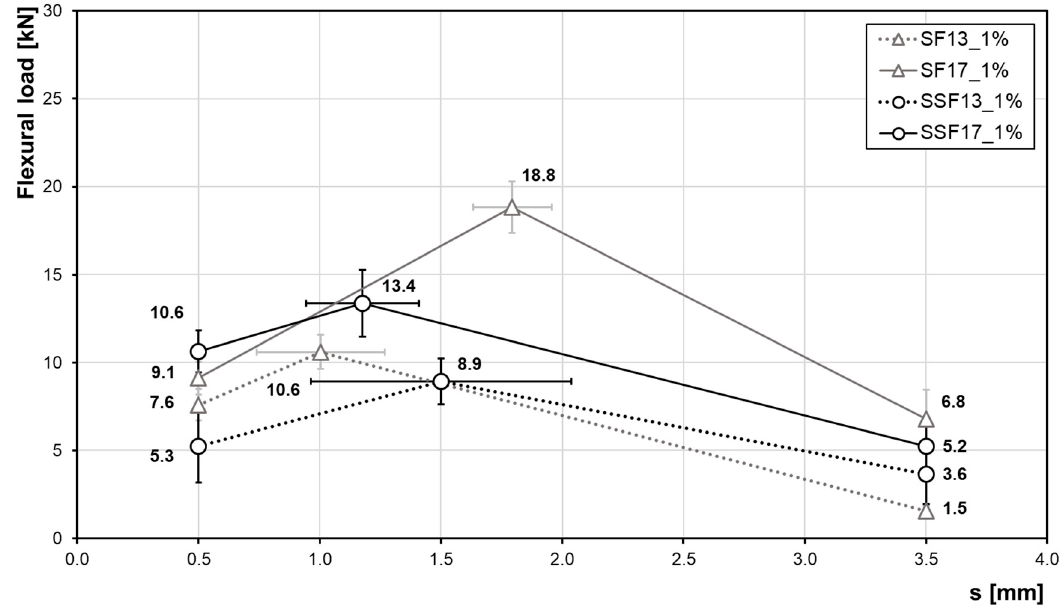
Figure 11. Influence of fibre material and length (at a constant volume fraction of 1.0 vol%) on the flexural strength. Data shown highlight the flexural load at a distance of 0.5 mm, 3.5 mm and the maximum load including standard deviations.